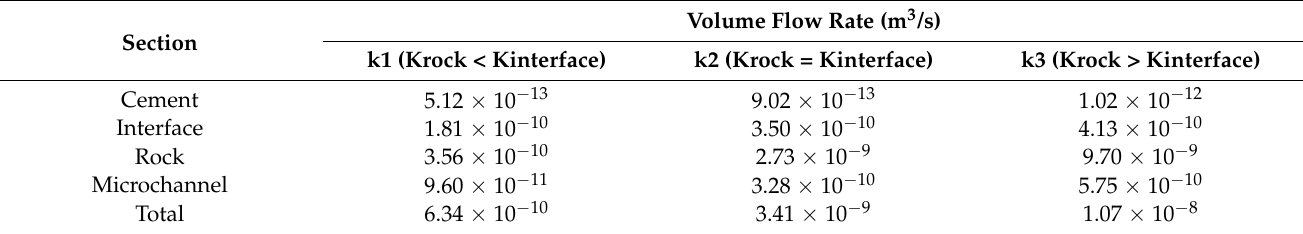
Table 13. Volume flow rate through cement–rock samples with microchannels and variable rock permeability.